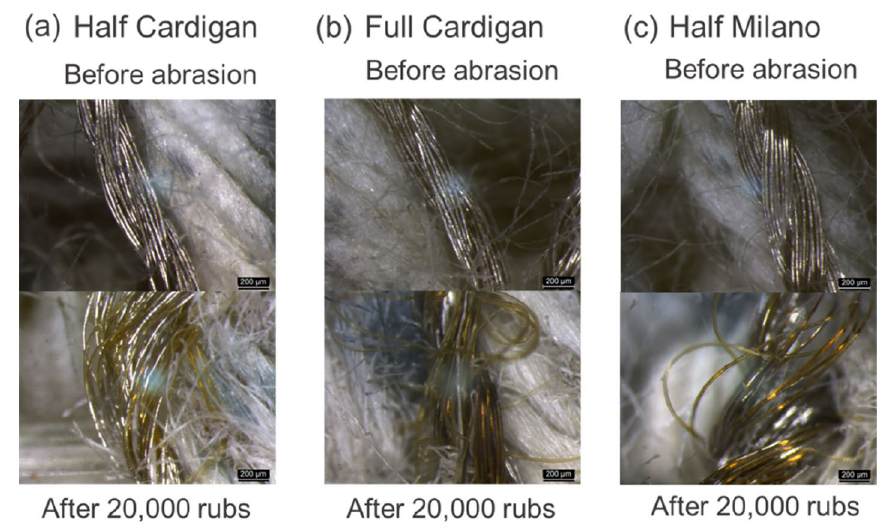
Fig. 10 Optical microscopic images of knitted textile before and after abrasion of 20,000 rubs: a Half Cardigan; b Full Cardigan; and c Half